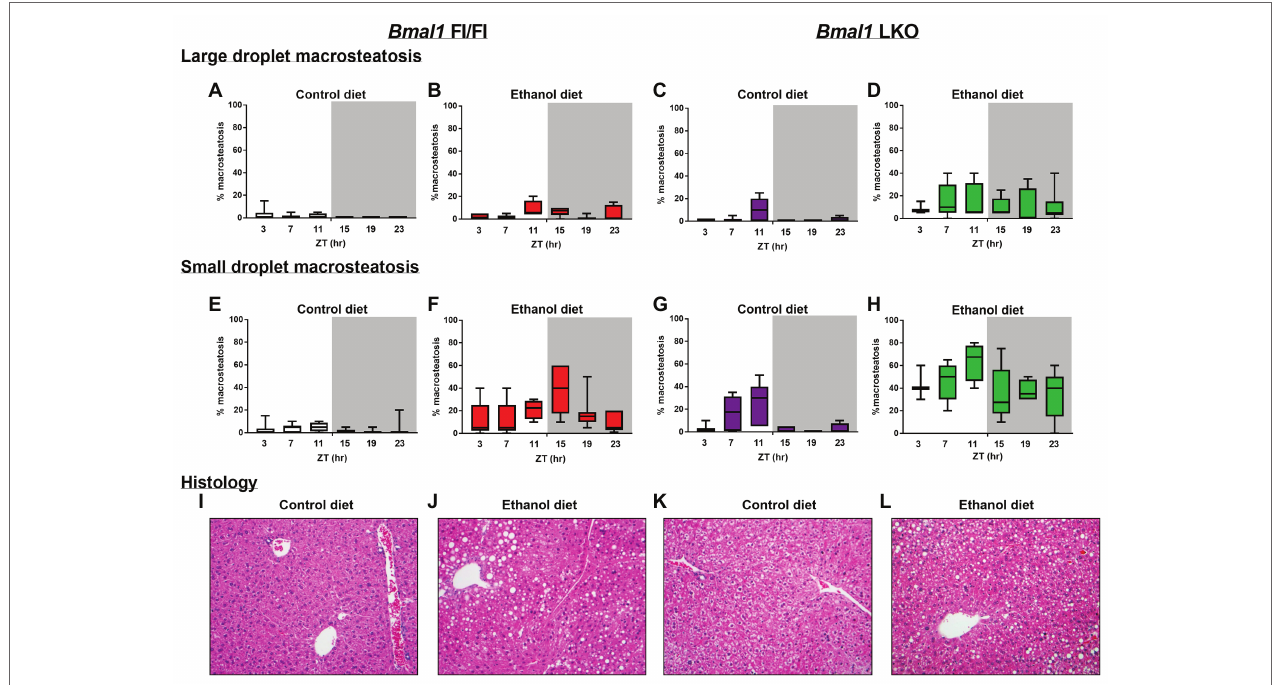
FIGURE 3 | Chronic alcohol and liver clock disruption enhance liver histopathology. Large droplet (A–D) and small droplet (E–H) macrosteatosis were assessed in H and E-stained liver sections prepared from control-fed ( A,E white) and alcohol-fed ( B,F red) Bmal1 Flox/Flox (Fl/Fl) and control-fed ( C,G purple) and alcohol-fed ( D,H green) Bmal1 liver-specific knockout (LKO) mice at ZT 3, 7, 11, 15, 19, and 23 (ZT 0: lights on/inactive period, ZT 12: lights off/active period, gray area). Liver sections were scored at multiple magnifications. Data represent the percentage of hepatocytes containing large and small droplet macrosteatosis per section. Results shown as min to max box and whisker plots for n = 3–8 mice/genotype/diet/time-point. (I–L) Representative H and E stained histology images from each group at ZT 15 (20X mag). Results for statistical analyses are provided in Table 1